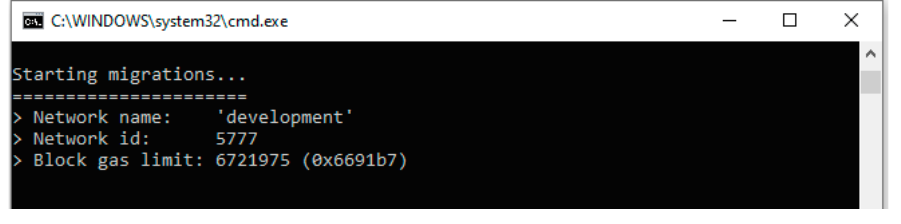
Figure 8. Migrate. Figure 8. Migrate.